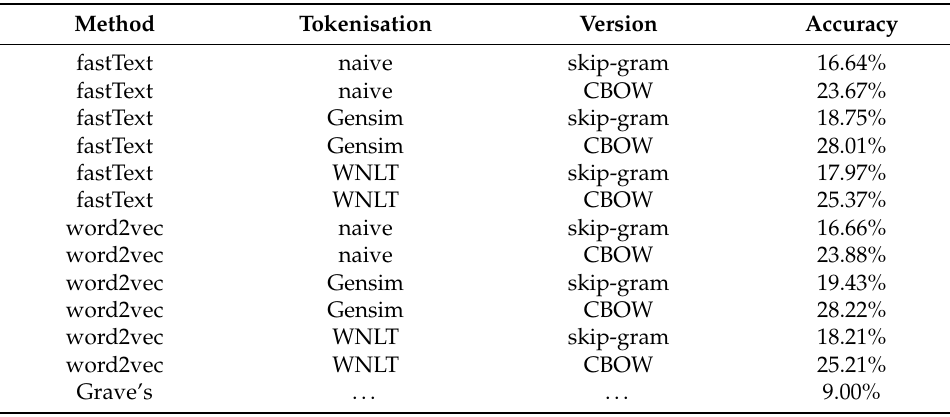
Table 6. The results achieved for the word analogy